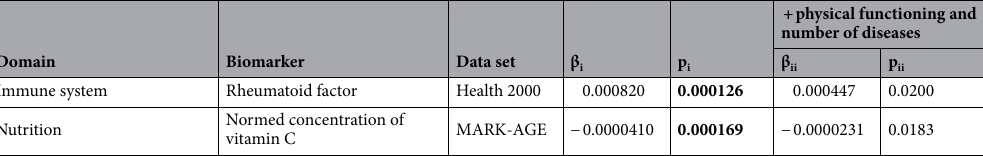
Table 3. Associations between biomarkers and SRH in linear regression analysis, adjusted for (i) age and gender and (ii) additionally for number of diseases and physical functioning. CRP C-reactive protein, HDL high-density lipoprotein, LDL low-density lipoprotein, NMR nuclear magnetic resonance, VLDL very low- density lipoprotein. The Table shows 46 biomarkers that were available for analysis in one data set only and were associated with SRH in Model (i). 19 of them were associated with SRH also in Model (ii). The results for all biomarkers are shown in Supplementary information 1. Statistical significance level was at Bonferroni- adjusted p value of 0.05, and p values below this threshold are shown in bold.